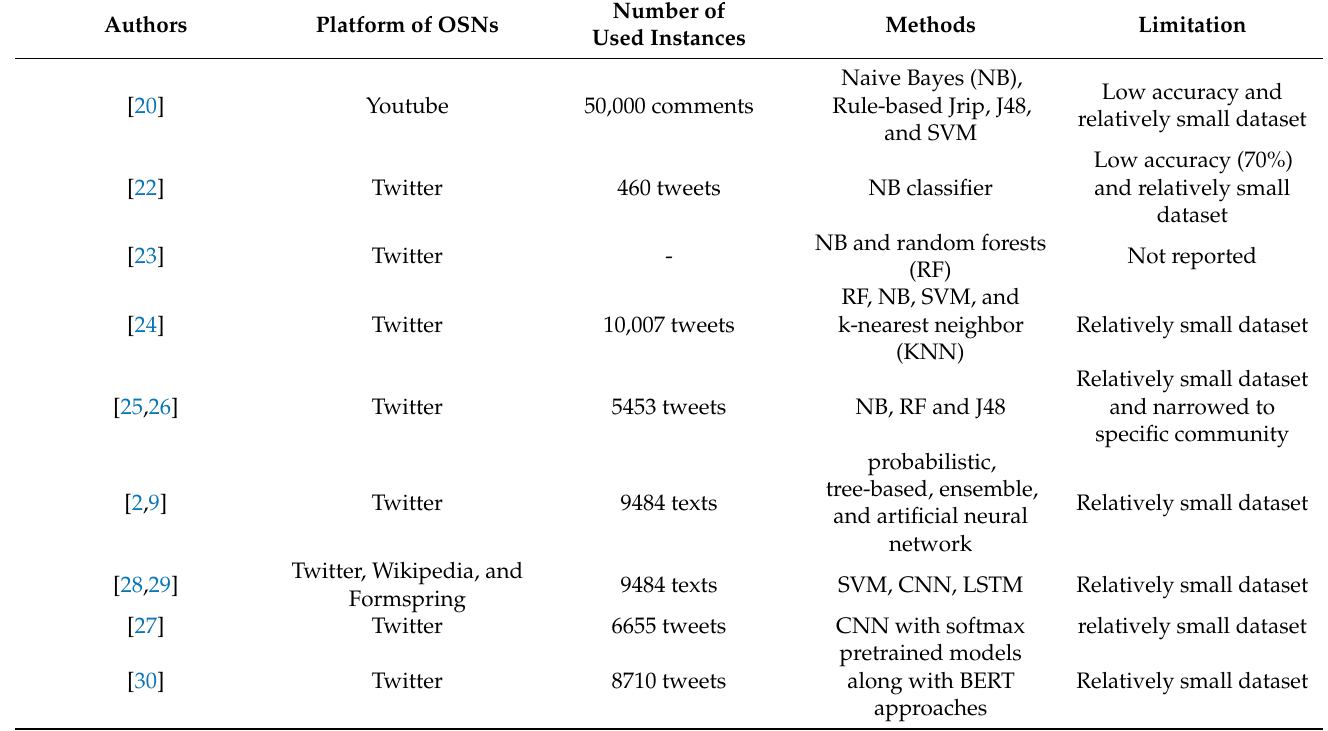
Table 1. Summery of the related